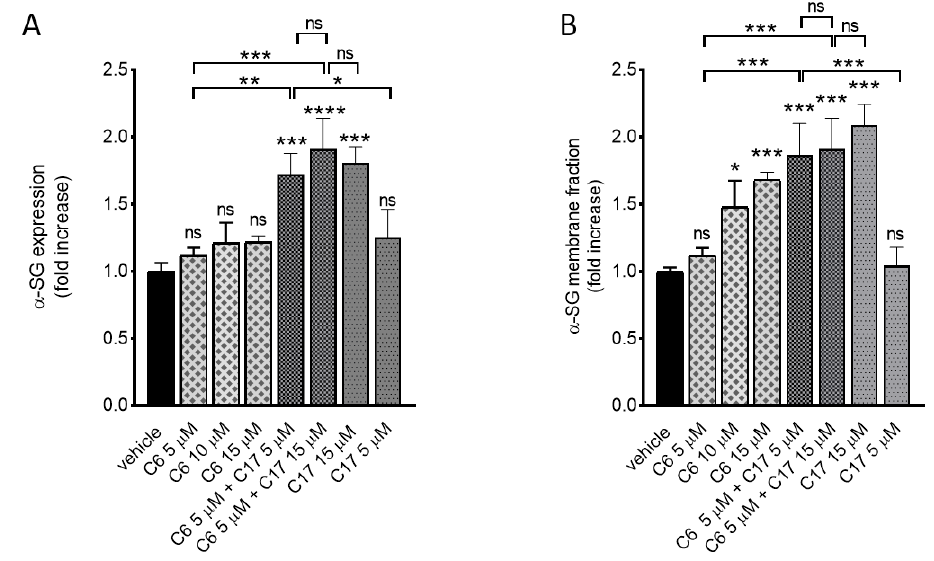
Figure 3. Additive/synergistic effects of C6 in combination with C17. Myogenic cells from a patient carrying the L31P/V247M α-SG mutations were differentiated for 7 days and treated for the last 72 h with either 1‰ DMSO (vehicle), C6, C17 or C6 + C17 at the indicated concentrations. At the end of incubation, myotubes were treated as described in the legend of Figure 2. Representative western blots are reported in Figure S4. ( A ) Quantification of α -SG content by densitometric analysis of the total protein lysates and ( B ) of the biotinylated fraction of proteins. Values are the mean ( +/ − SD) of 3–4 independent experiments (each performed in duplicate) and are reported as fold increase of the amount present in the control sample. Statistical analysis was performed by One-way ANOVA test followed by multiple comparisons Tukey’s test; n.s., p > 0.05; *, p ≤ 0.05; **, p ≤ 0.01; ***, p ≤ 0.001, ****, p ≤